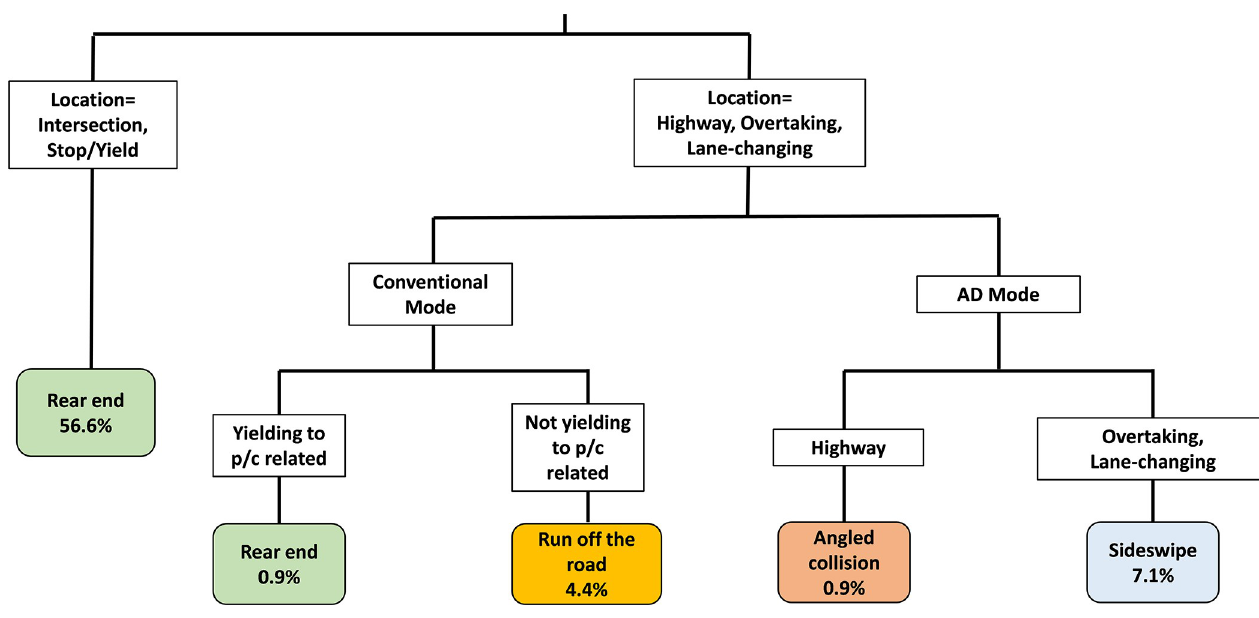
Fig 4. Classification tree of collision type in AD